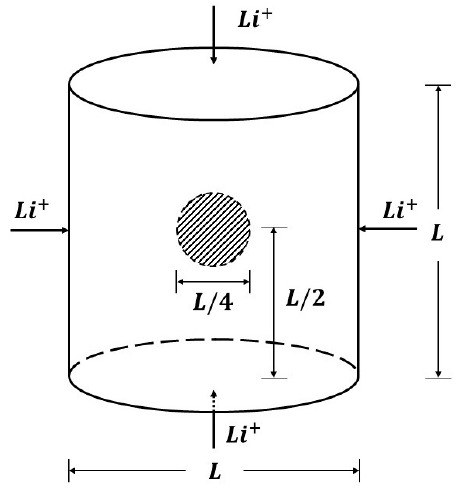
Figure 9. Cylindrical anode structure with a pre-existing vertical crack.